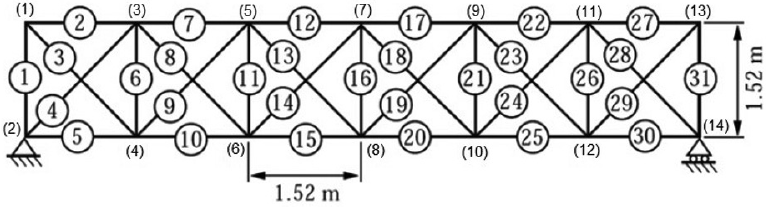
Figure 6. The 31-element planar